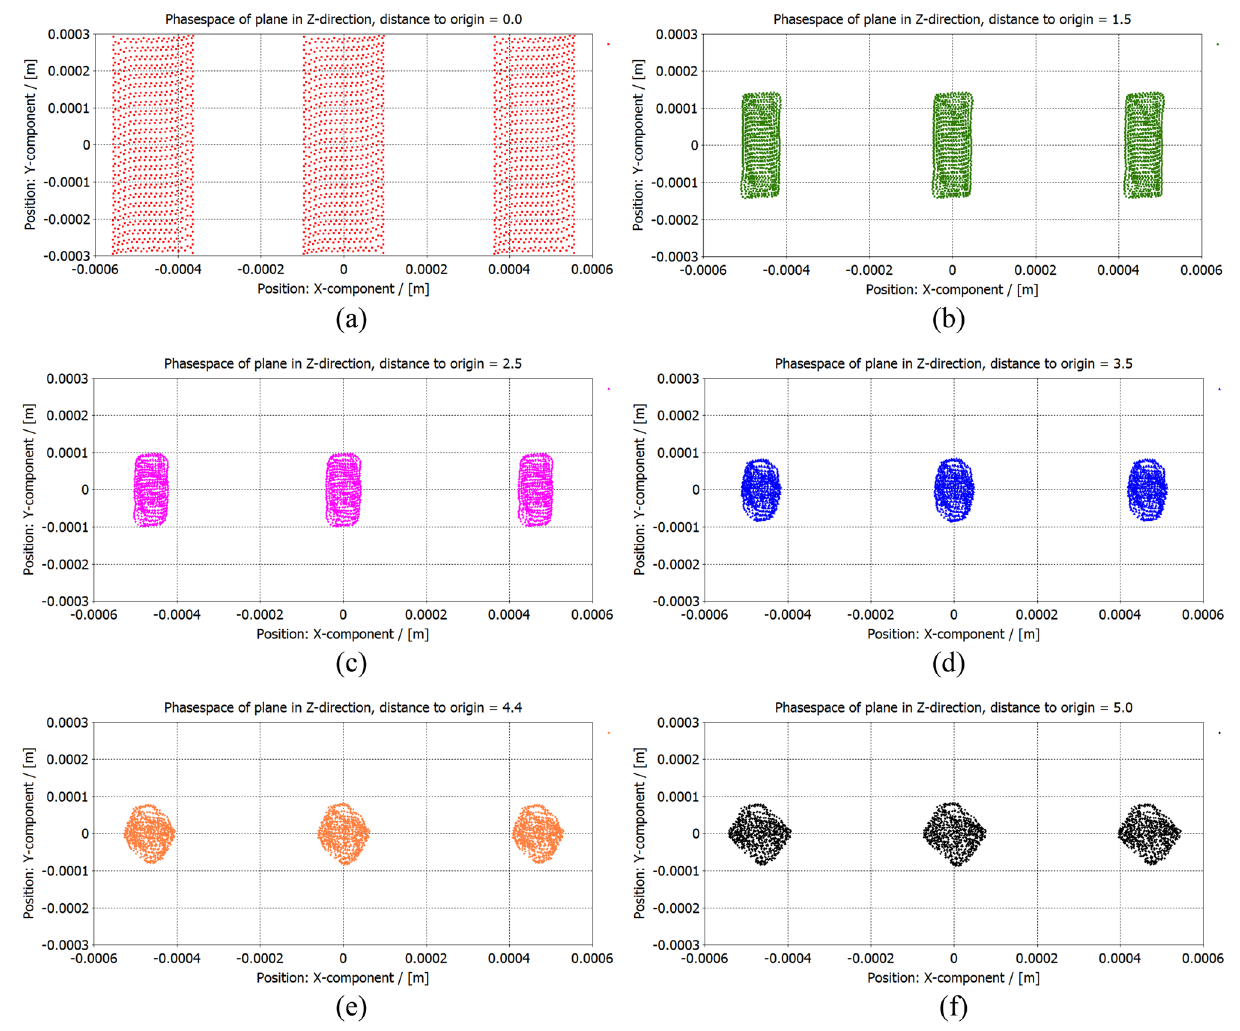
Figure 15. Beam cross-section along the direction of beam transport. ( a ) z = 0, ( b ) z = 1.5 mm, ( c ) z = 2.5 mm, ( d ) z = 3.5 mm, ( e ) z = 4.4 mm, ( f ) z = 5.0